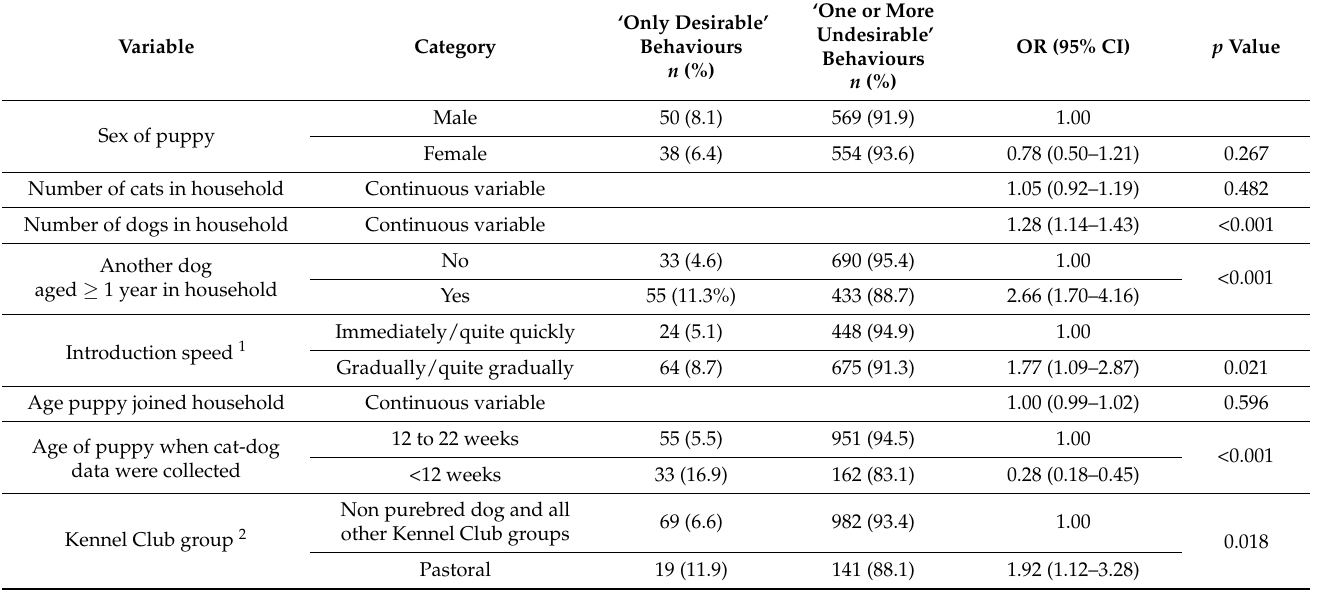
Table 4. Univariable logistic regression models of odds ratios (ORs), 95% confidence intervals (CIs) and p values of potential explanatory variables for ‘only desirable’ behaviour from puppies following introduction to existing household